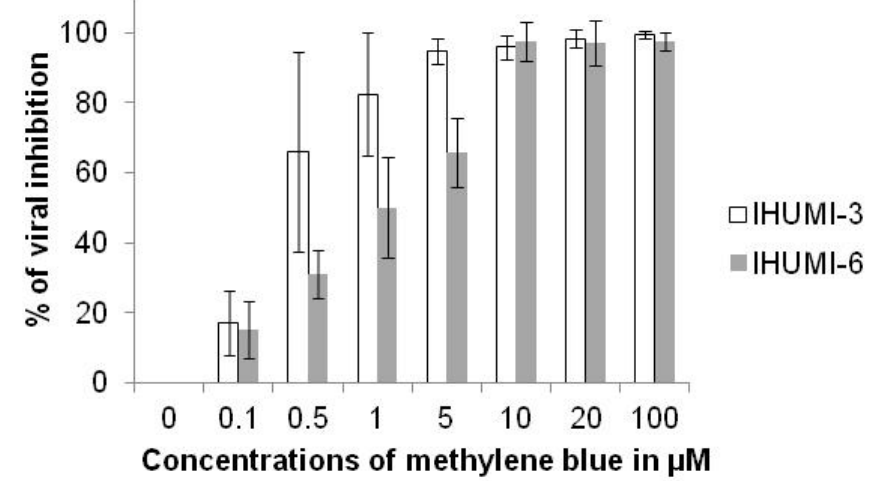
Figure 1. Anti-SARS-CoV-2 activity of methylene blue in % of antiviral inhibition on IHUMI-3 (mean of 12 independent experiments) and IHUMI-6 (mean of 6 independent experiments) clinically-isolated strains (error bar represents standard deviation).